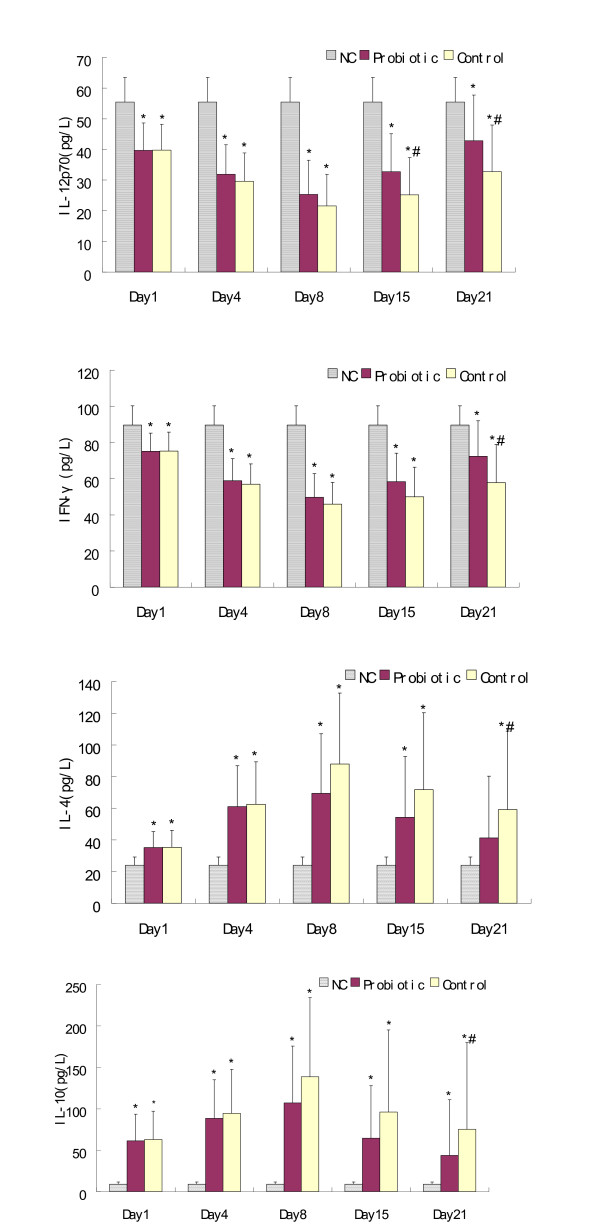
Serum IL-12p70, IFNγ, IL-4, and IL-10 concentrations. Mean ± standard deviation. *P < 0.05, compared with normal controls (NC). #P < 0.05, compared with the probiotic group.